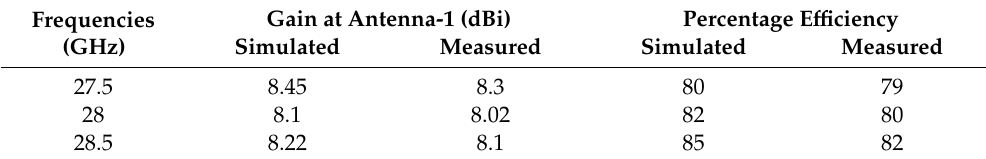
Table 2. Measured and simulated gain and efficiency.